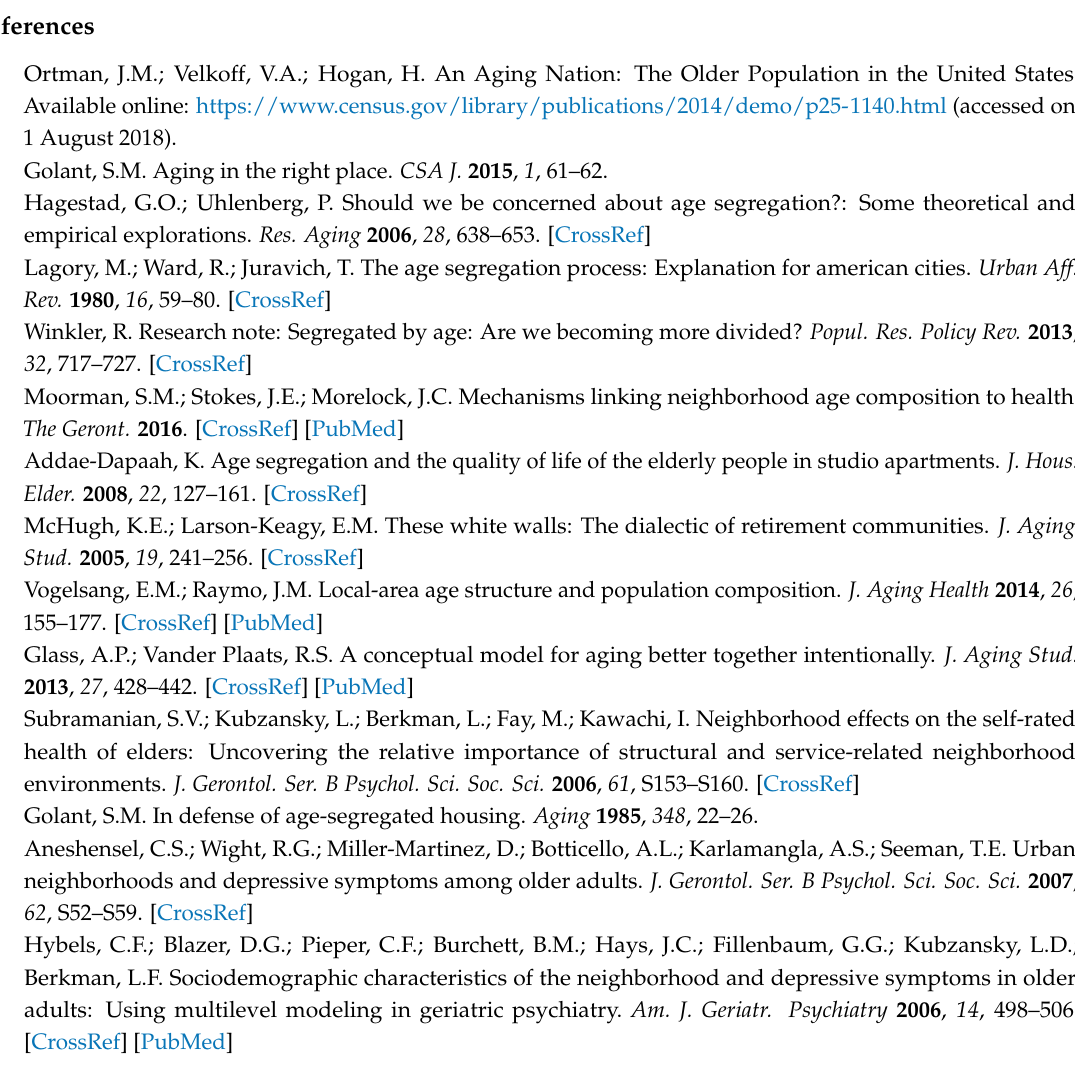
Table S1: 25 MMSAs with Most Age Segregation Index and 25 with Least Age Segregation Index, 2010. Figure S1: Scatterplot of age segregation index vs. MMSA growth rate 2000-2010. Statistical test shows that the correlation between them is significantly positive. Figure S2: Scatterplot of age segregation index vs. logarithm of area of MMSAs. Statistical test shows that the correlation between them is significantly positive. Table S2. Multilevel Models Predicting Variation in MENTHLTH among Elderly Populations. Table S3. Multilevel Models Predicting Variation in PHYSHLTH among Elderly Populations. Table S4. Multilevel Models Predicting Variation in GENHLTH among Elderly